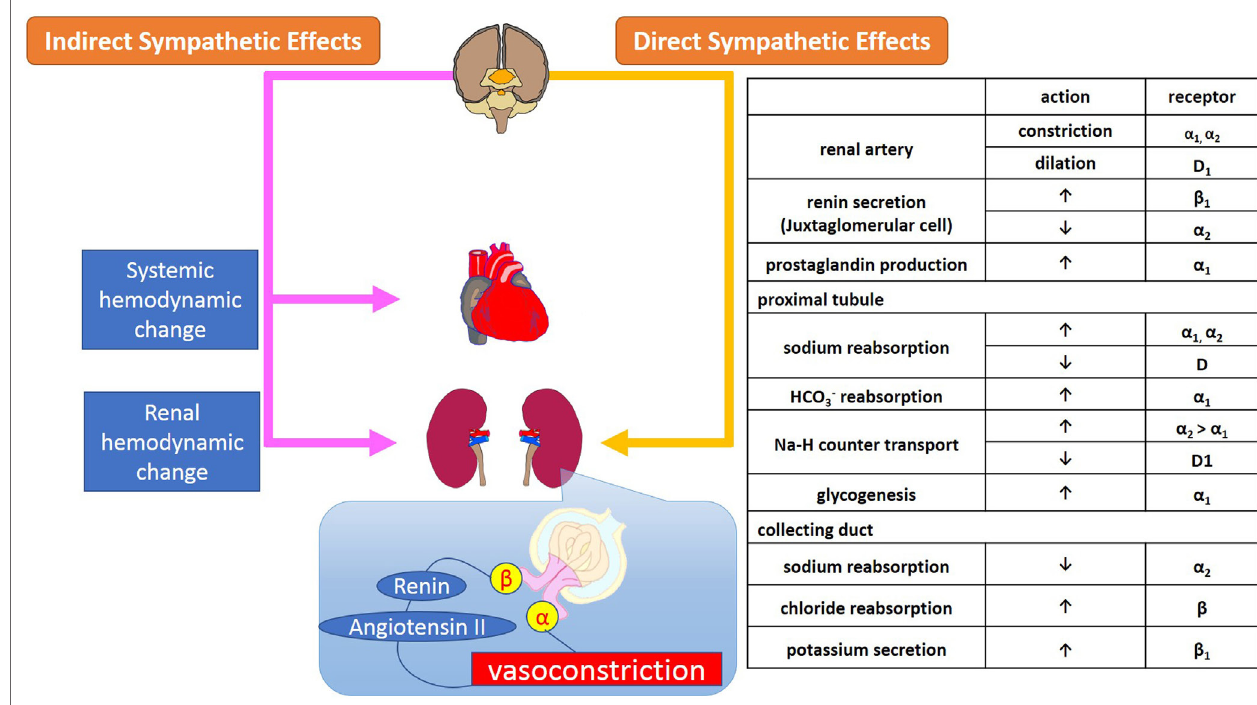
FigURe 1 | Sympathetic regulation of renal function; glomerular filtration and reabsorption of electrolytes, sodium, and water in kidneys. Sympathetic regulation of kidney function consists of systemic and renal hemodynamic modulation, sympathetic effects via secretion of neurohumoral agents, and direct adrenergic and dopaminergic effects on receptors on renal arterioles and